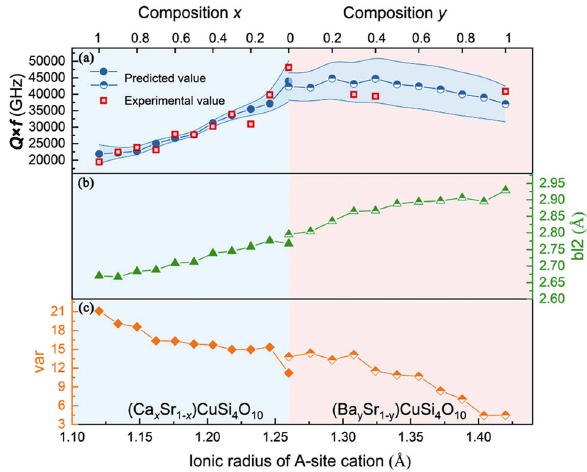
Fig. 30 Machine learning prediction results. (a) Experimental and predicted Q × f values, (b) feature of bl2 (bond length of A–O 2 bond), and (c) feature of var (variance in bond lengths of A–O bond) of (Ca x Sr 1– x )CuSi 4 O 10 and (Ba y Sr 1– y )CuSi 4 O 10 ceramics. The shadow area in (a) represents the standard error of 100 trials. Reproduced with permission from Ref. [602], © American Chemical Society